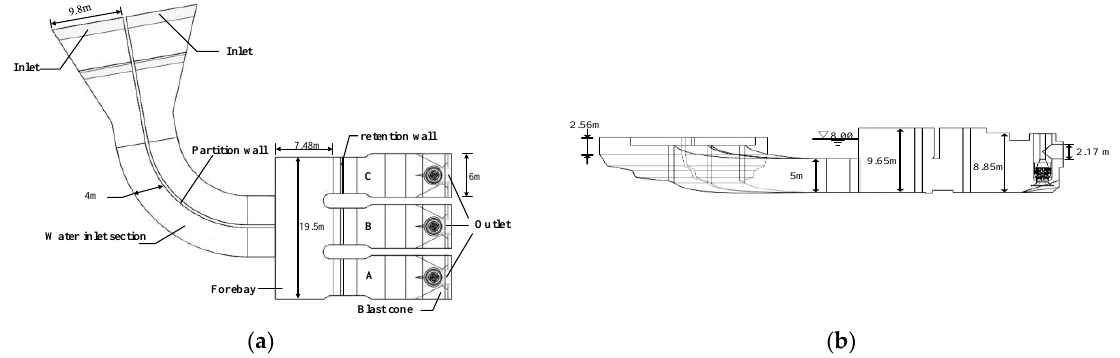
Figure 3. Structure diagram of inlet channel. ( a ) Vertical view. ( b ) Lateral view.